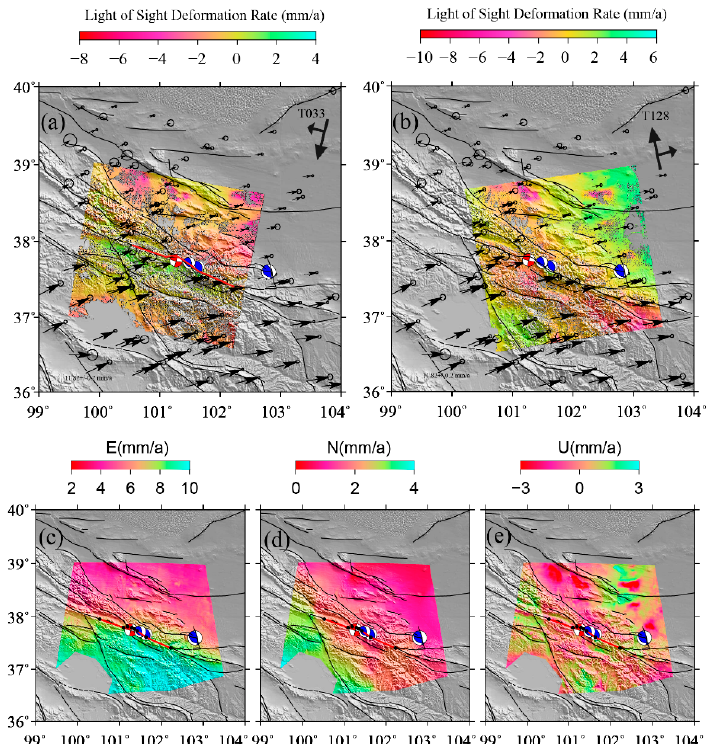
Figure 2. Distribution of temporal and spatial baselines of the interferograms. Crosses with purple labels represent images included in velocity calculations, whereas crosses with cyan labels represent images that were not included. Purple lines represent generated interferograms. ( a ) Track A128; ( b ) Track D33.